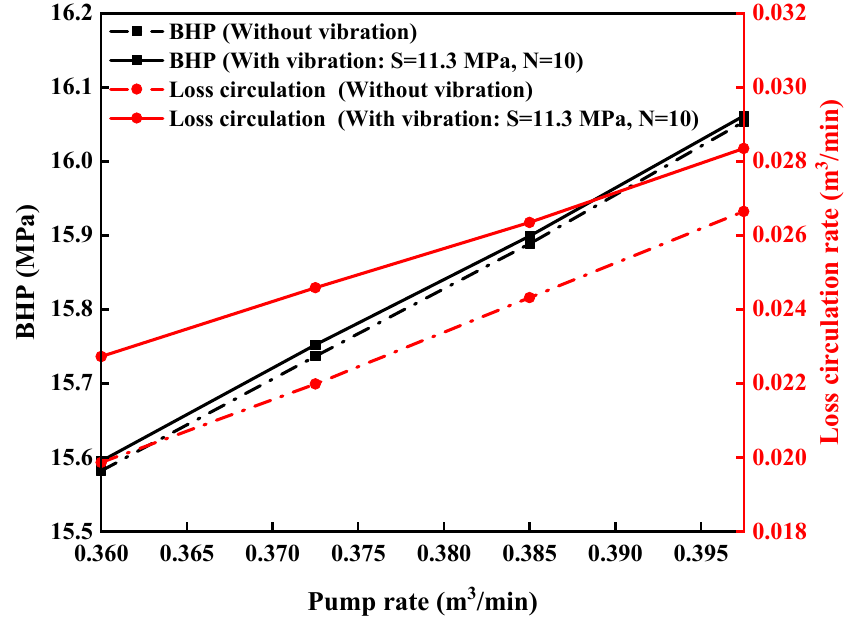
Figure 17. Effect of pump rate on loss circulation rate and BHP with and without vibration cyclic loads.